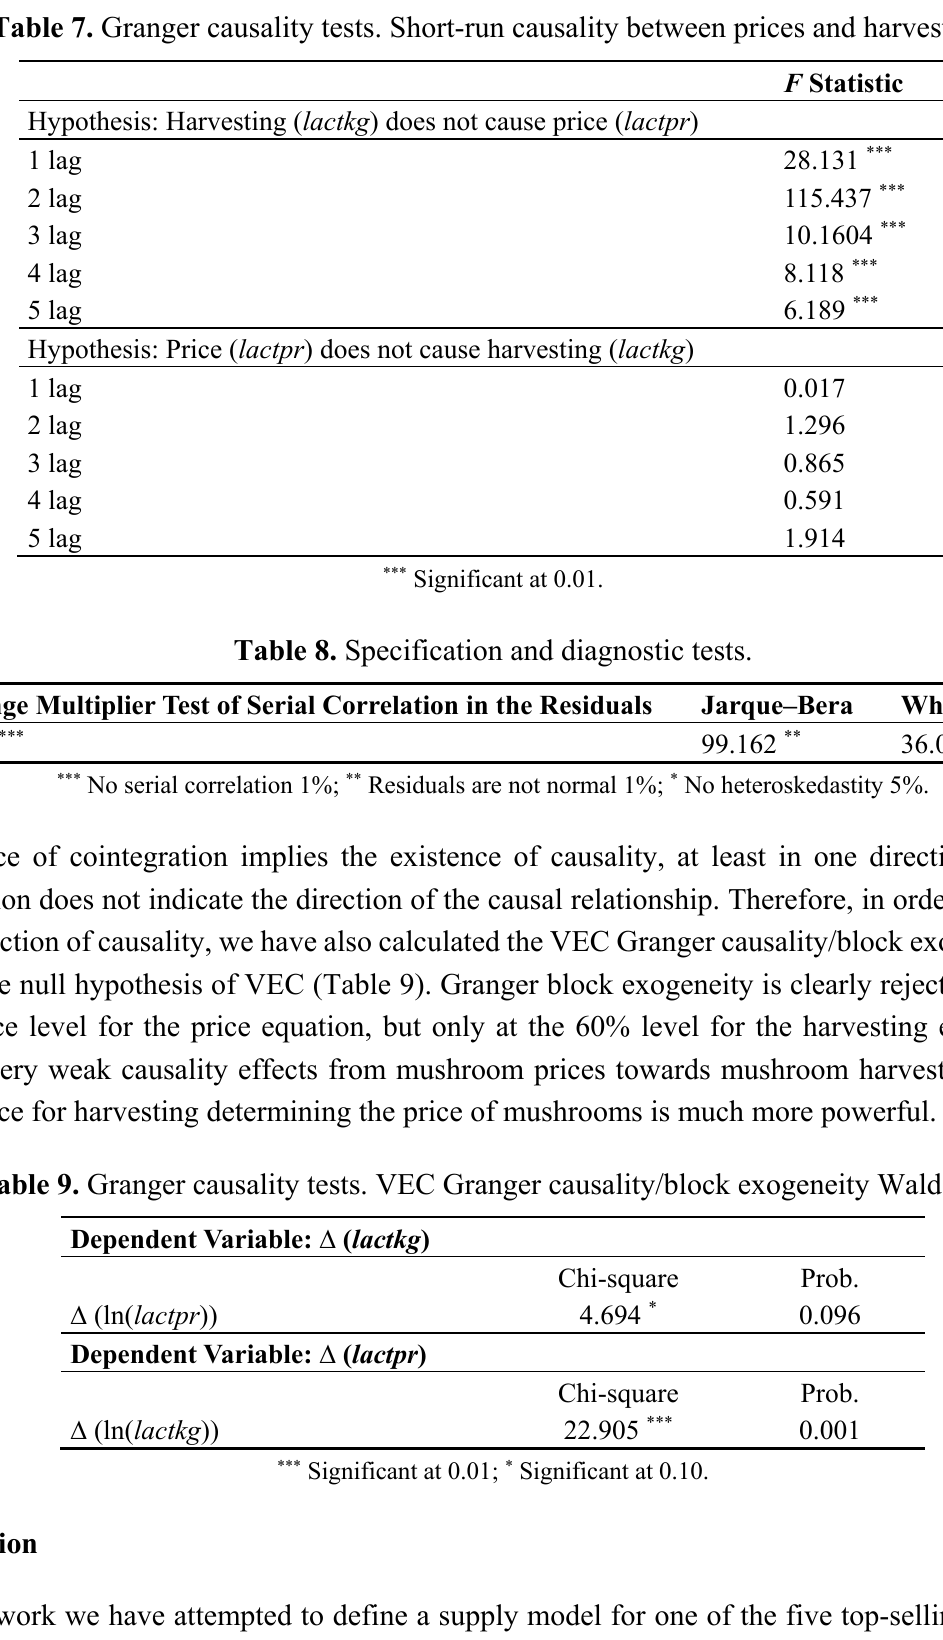
Table 7. Granger causality tests. Short-run causality between prices and harvesting.